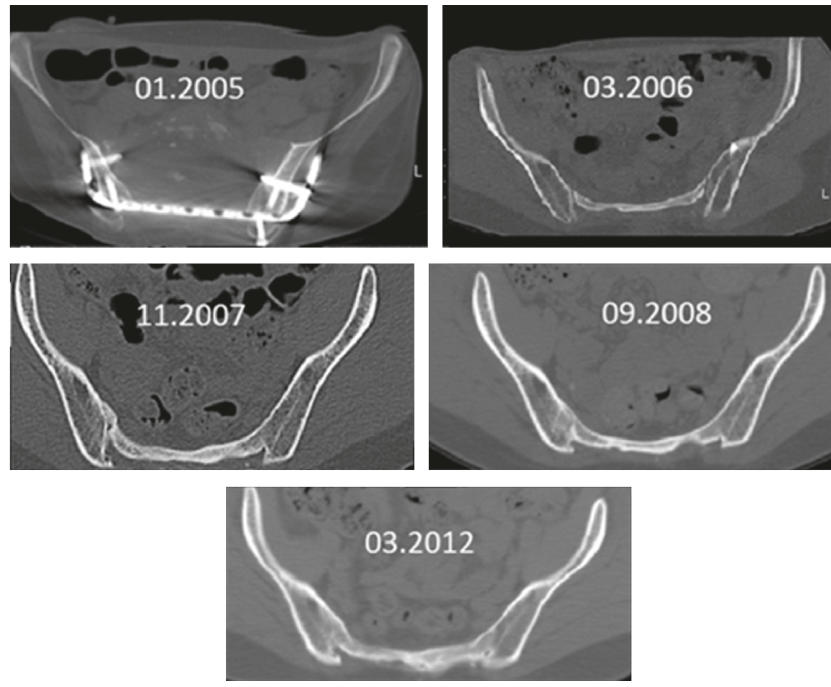
Figure 7: Sacral osteoneogenesis over the course of time in axial slices.